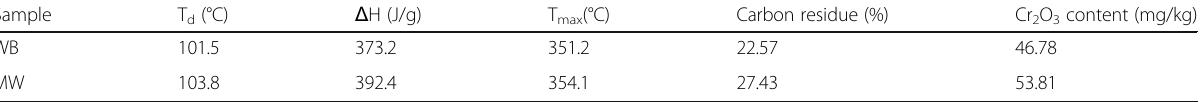
Table 5 The thermal behaviors and chrome content of hide powder tanned by chrome tanning liquor treated by different method Sample T d